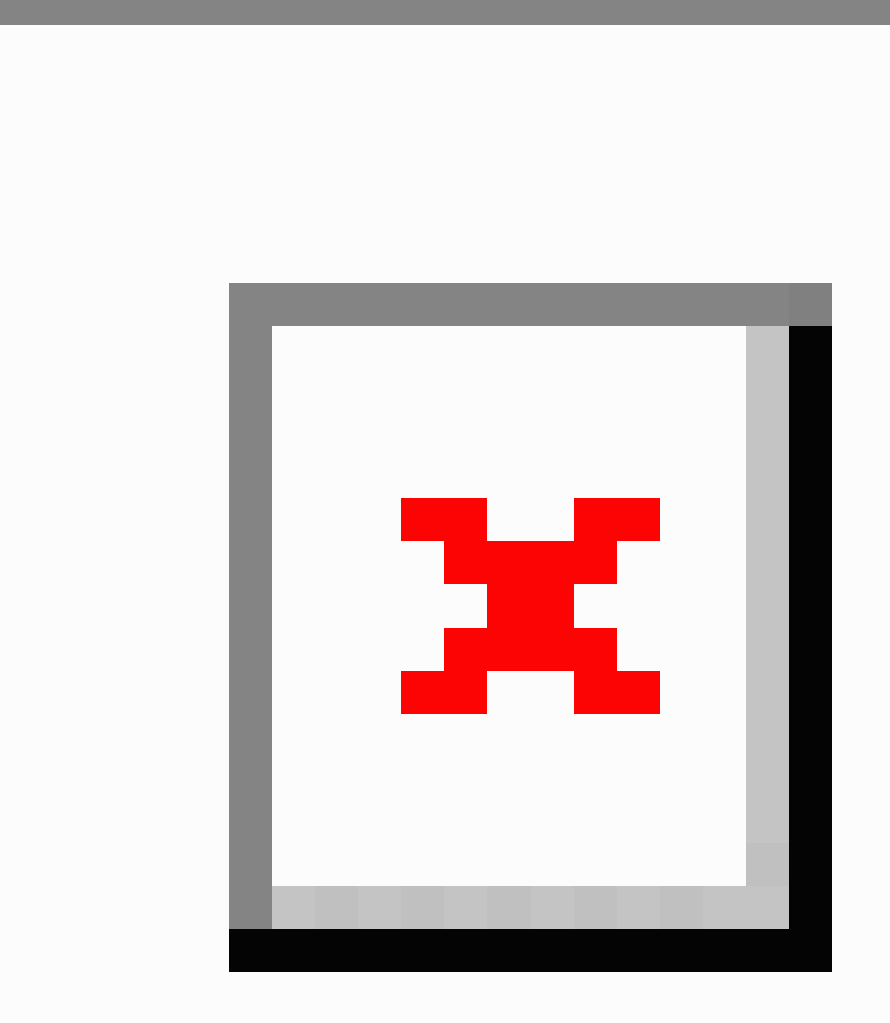
Figure 3. Mobile phone screenshot showing steps/day graph on P-Mobile